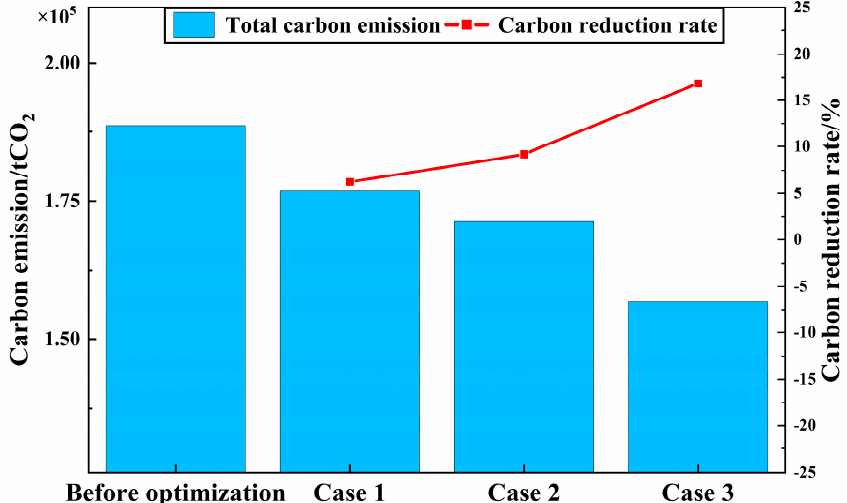
Figure 14. Total carbon emissions and carbon-reduction rates in the three cases and before optimization of the IEEE 118-bus system.